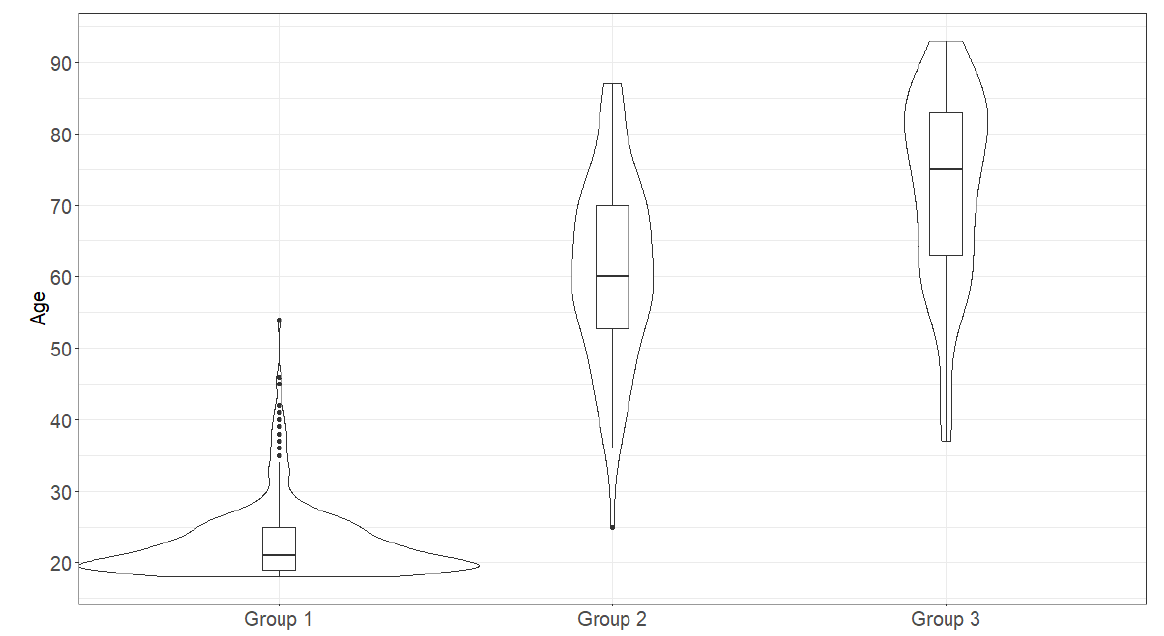
Figure 2. Age distribution in the studied samples. Table 3. Difference in age distribution in the studied